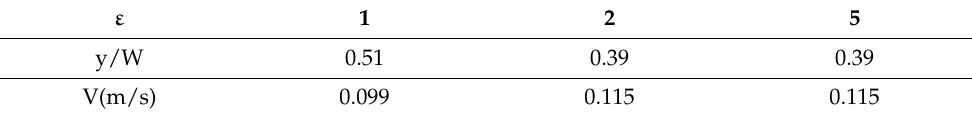
Figure 12. The distributions of velocity under different aspect ratios: ( a ) ε = 0.2; ( b ) ε = 0.5; ( c ) ε = 1; ( d ) ε = 2; ( e ) ε = 5. Table 3. The flow velocity at the initial mass transfer area position when ε = 1, 2 and 5.